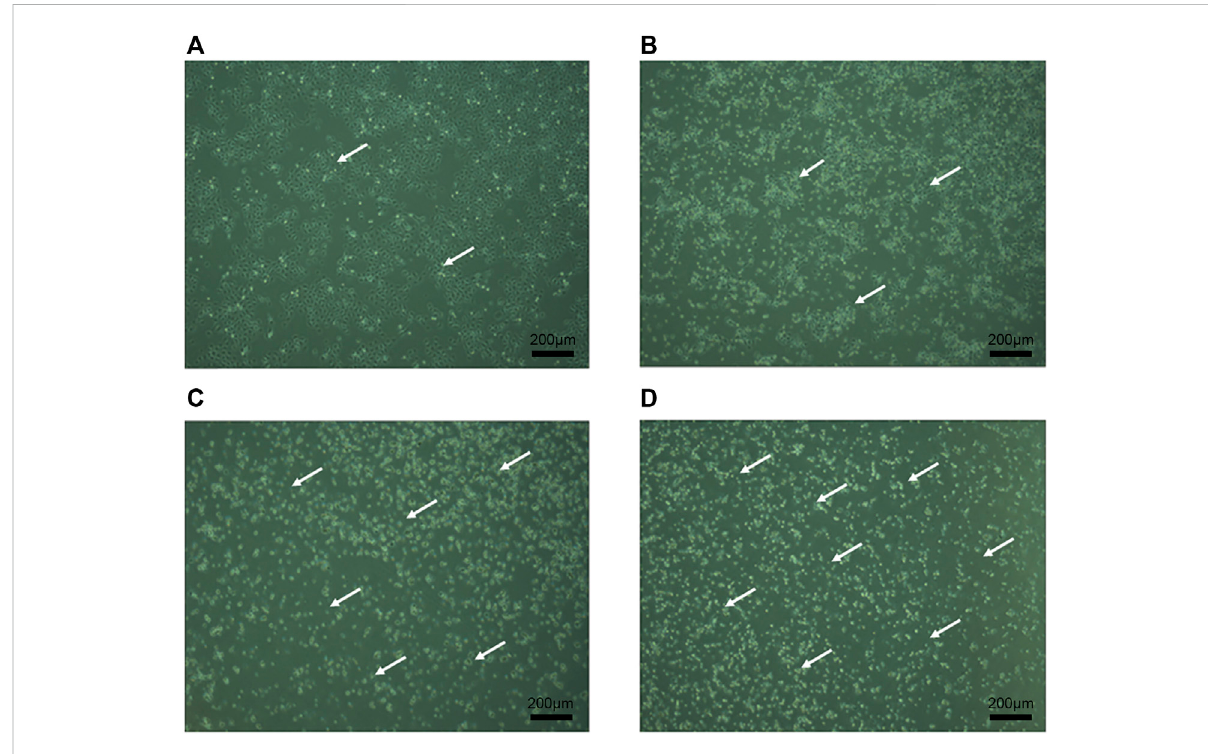
FIGURE 3 Morphological observation of CaSki cells. Note: (A) : Control group was treated for 24 h with CaSki cell morphology. (B) : 5 μ M RPDPRH was treatedfor24 hwithCaSkicellmorphology. (C) :10 μ MRPDPRHwastreatedfor24 hwithCaSkicellmorphology. (D) :15 μ MRPDPRHwastreatedfor 24 h with CaSki cell morphology. Scale bar: 200 μ